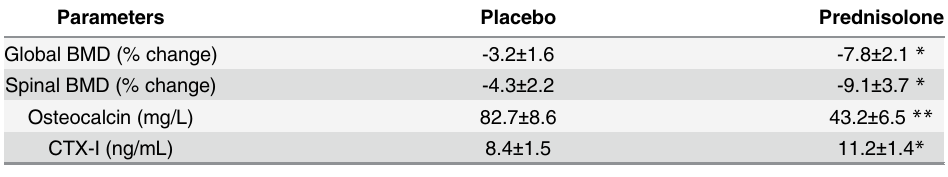
Table 1. BMD and serum biochemical measurements in mice with and without 4-week prednisolone administration. Data shown are the mean ± SD. There are ten animals per group.